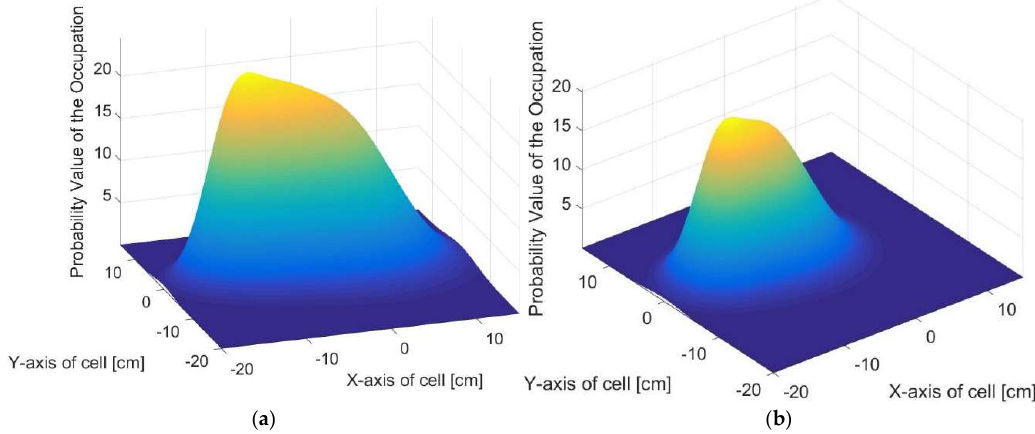
Figure 7. Representation of the dynamic movement using successive Gaussian kernels: ( a ) a long period of the history information; and ( b ) a short period of the history information.